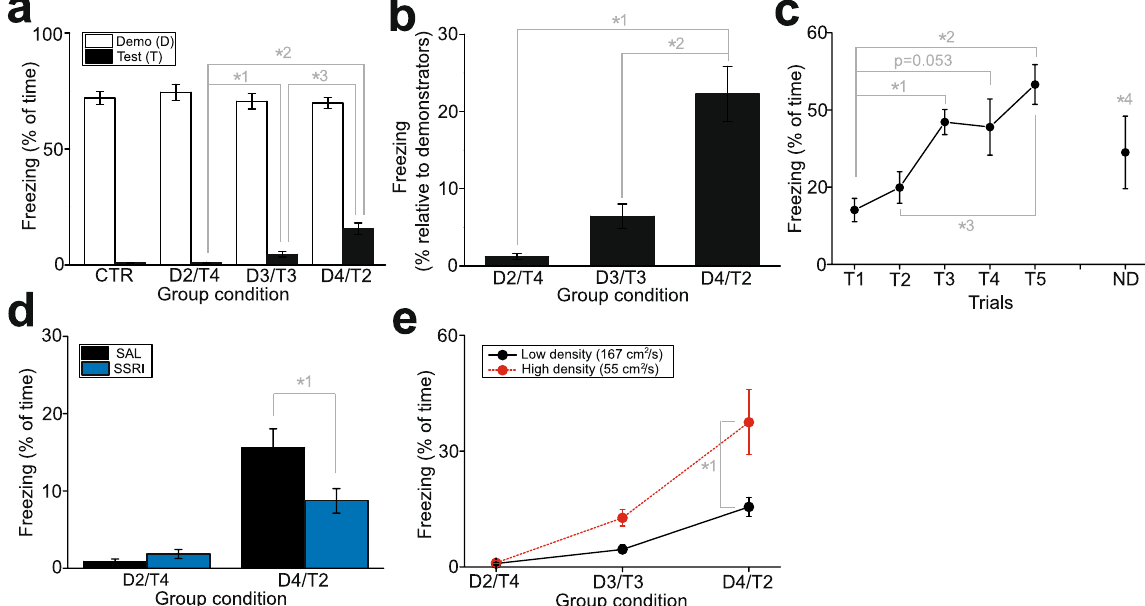
Figure 5. Decision-making under conflict in social conformity-like behavior and the effects of SSRI. ( a ) A graph showing freezing of demonstrators (D) and test subjects (T) with SAL in different group conditions. Control groups in which all 6 mice were subjected for fear conditioning or none of them were conditioned is denoted as CTR. * 1–3 p < 0.001. ( b ) A graph similar to ( a ), but showing as percentages that the test subjects expressed freezing relative to the demonstrators in different group conditions. * 1–2 p < 0.001. ( c ) A graph showing growing freezing of test subjects in the D4/T2 conditions with repeated trials (T1-T5), and one additional trial, but without demonstrators in the cage (ND; 6th trial). * 1 p = 0.037, * 2 p = 0.002, * 3 p = 0.012, * 4 p = 0.017. ( d ) A graph showing freezing of test subjects with SAL (data shown in ( a )) and